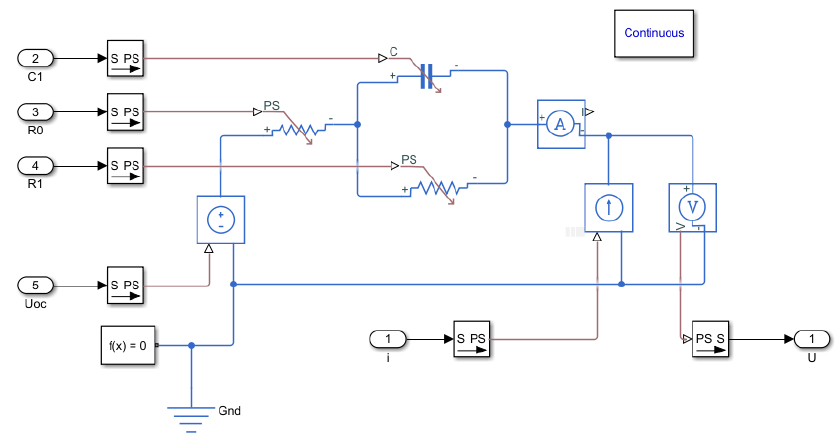
Energies 2020 , 13 , 2057 Figure 8. The internal structure of Thevenin model. Figure 8. The internal structure of Thevenin model.